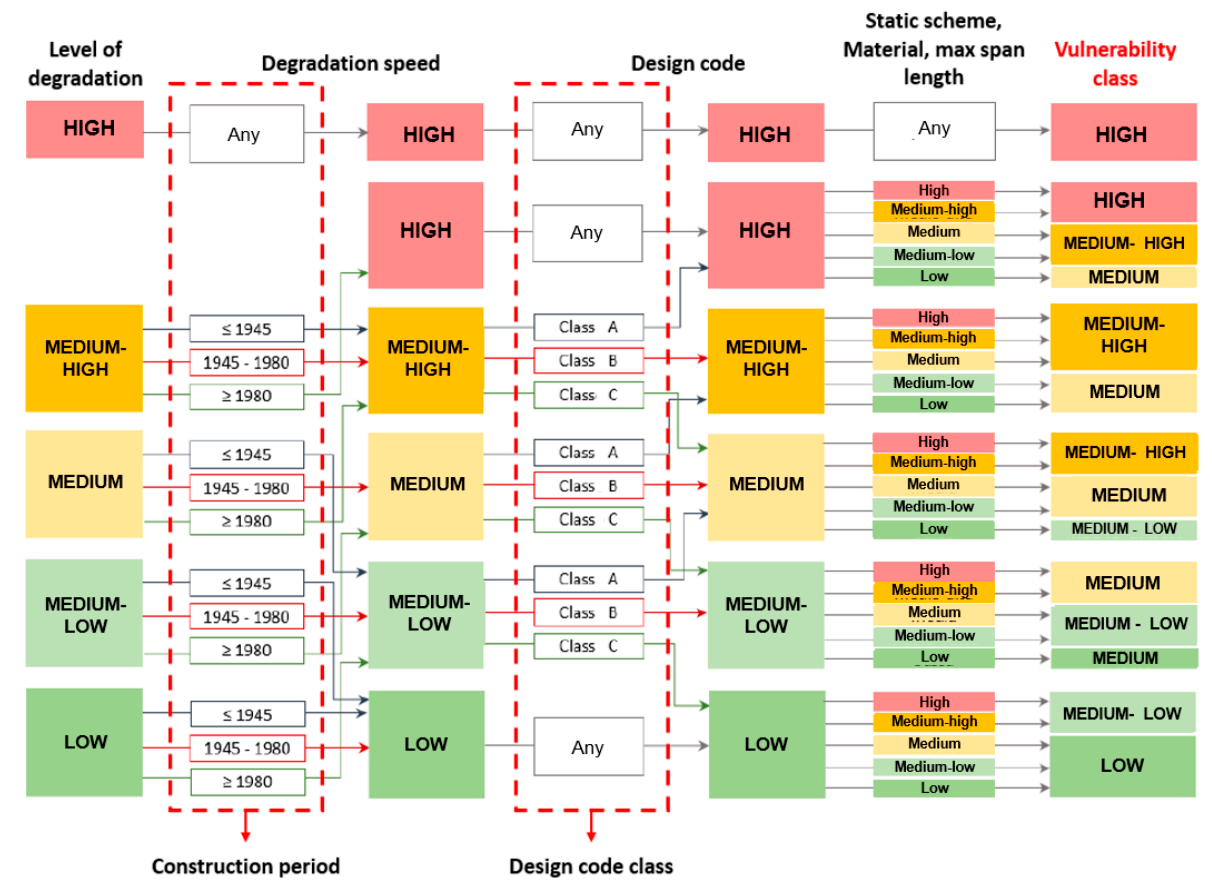
Figure 7. Logical path for the determination of the vulnerability class [15].